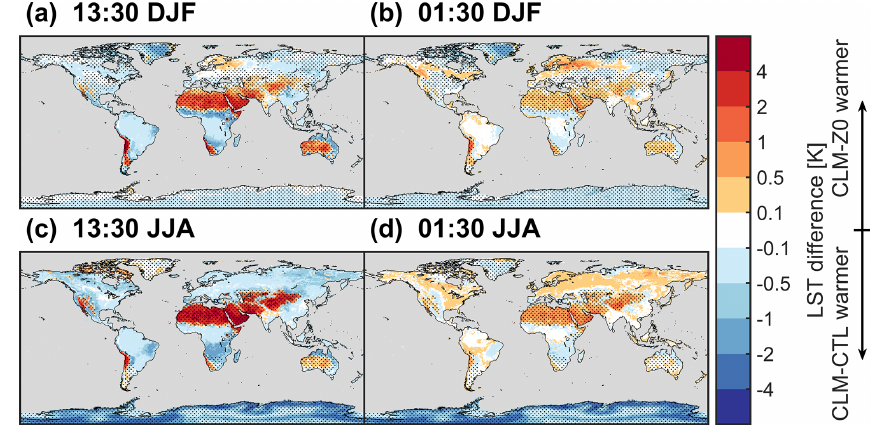
Figure 7. LST difference between CLM-Z0 and CLM-CTL. (a, c) LST difference at 13:30 local solar time and (b, d) difference at 01:30 local solar time. (a, b) Boreal winter (DJF) and (c, d) boreal summer (JJA). The stippling shows areas dominated by bare soil with a seasonal average VAI below 0.5m 2 m − 2 . Note the non-linear color